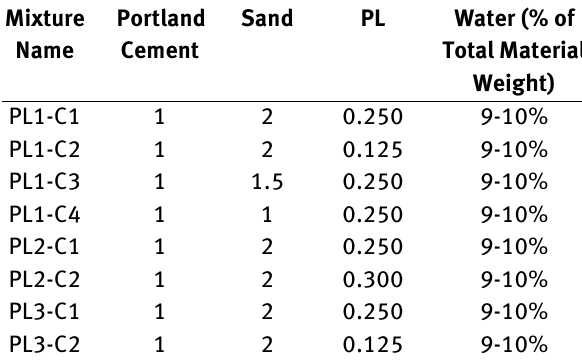
Table 2: Mixture designs for eco-bricks (proportions by weight) Mixture